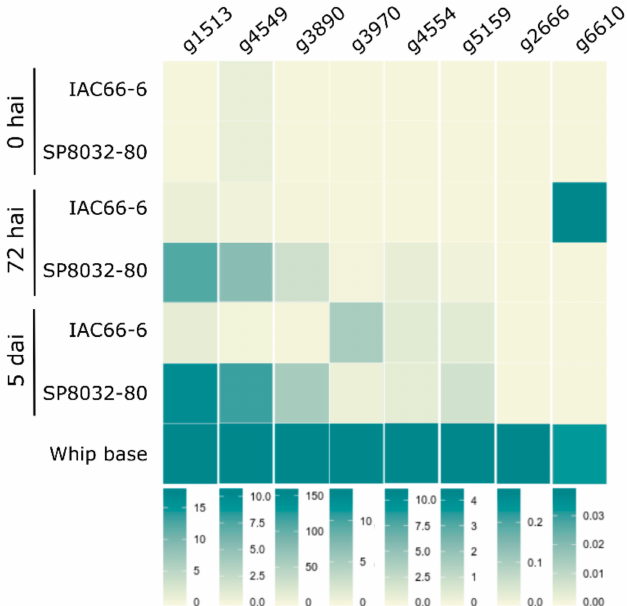
Figure 1. Candidate e ff ectors (CE) transcriptional profiles of the fungus during disease progression (0 and 72 hai, 5 dai, and after whip emission) after infecting smut-susceptible (IAC66-6) and -resistant (SP80-3280) sugarcane plants. CEs were grouped based on similar transcriptional profiles. Vertical bars indicate scales of relative expression. Heatmaps were generated based on Figure S8